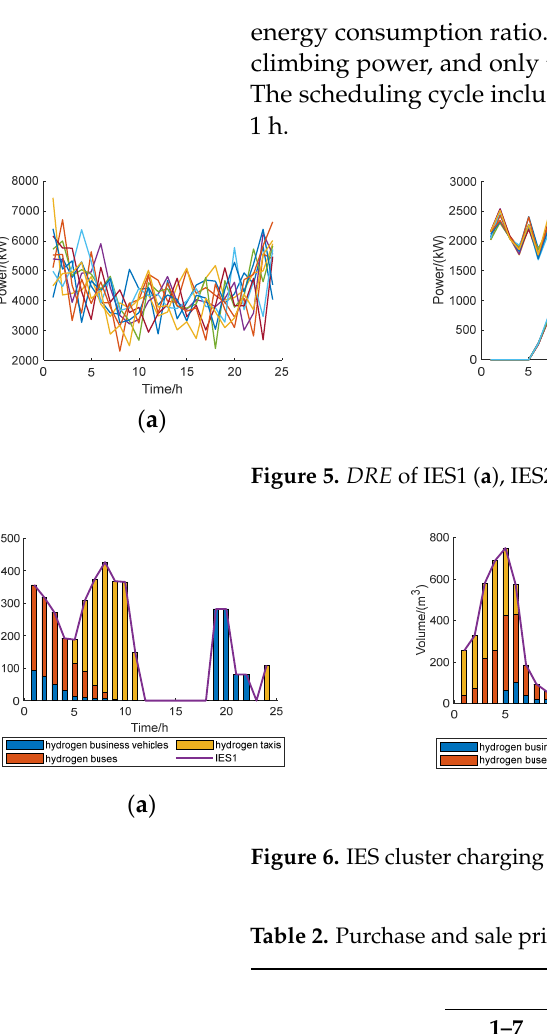
Table 3. Relevant